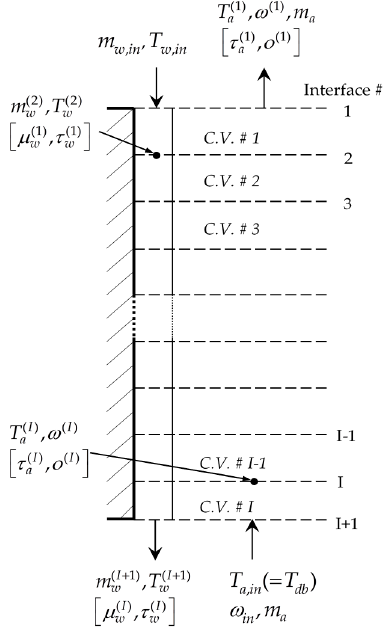
( ) = = Figure 2. Fill section nodalization comprising 49 control volumes ( i = 1,..., I = 49 ) ; both the Figure 2. Fill section nodalization comprising 49 control volumes 1,.., ; both the forward (cid:16) (cid:17) ( i ) ( i ) ( i ) ( i ) , m m forward state functions and the adjoint state functions selected a ; i = 1,..., I w , T w , T a , ω and the adjoint state functions selected (cid:16) (cid:17) ( i ) ( i ) ( i ) ( i ) , µ µ are shown in the a ; i = 1,..., I w , τ w , τ a , I are shown in the picture.